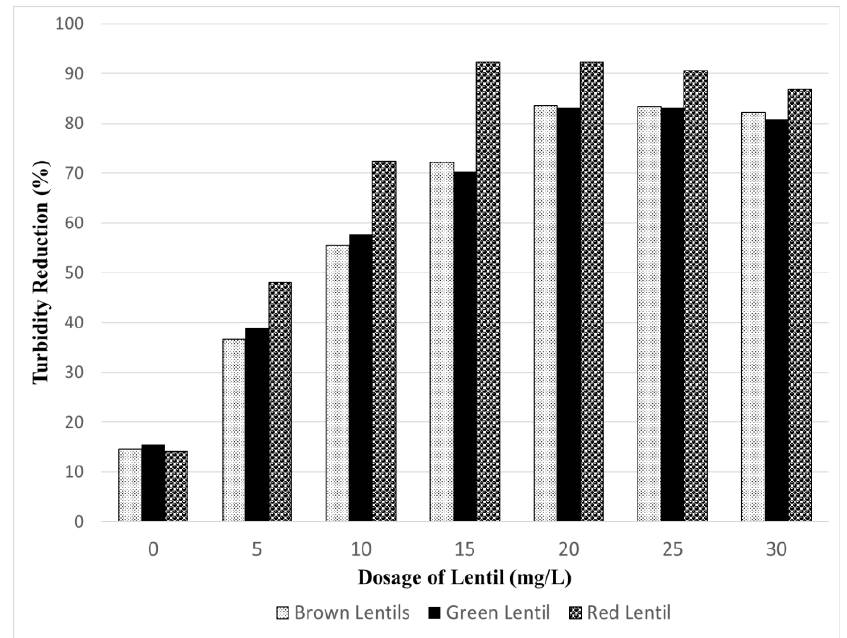
Figure 3. Turbidity reduction using brown, green and red lentil extracts as coagulant at pH 4.